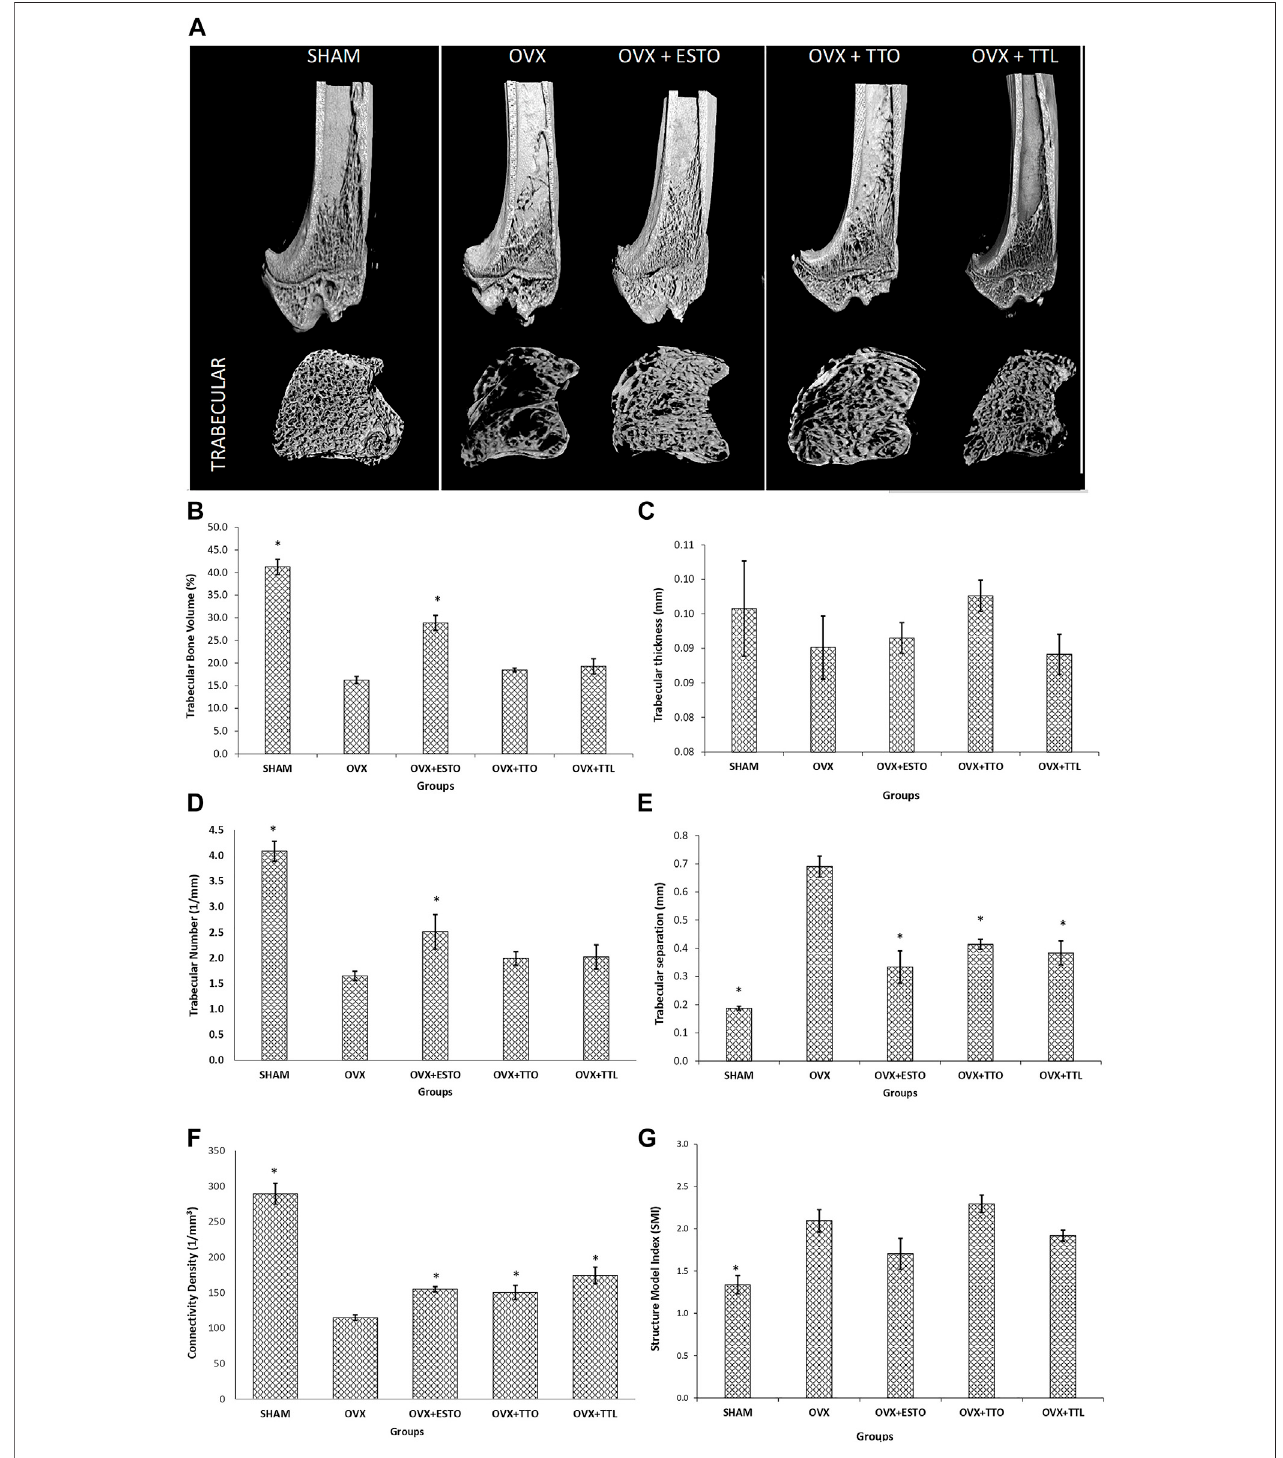
FIGURE 5 | Microcomputed tomography (micro-CT) parameters. (A) Three-dimensional (3D) images of tibial trabecular and cortical trabecular bones. (B) Trabecular bone volume of the tibial trabecular bone. (C) Trabecular thickness of the tibial trabecular bone. (D) Trabecular number of the tibial trabecular bone. (E) Trabecular separation of the tibial trabecular bone. (F) Connectivity density of the tibial trabecular bone. (G) Structure model index (SMI) of the tibial trabecular bone. SHAM, sham-operated group; OVX, ovariectomized control group; OVX + ESTO, ovariectomized + oral estrogen; OVX + TTO, ovariectomized + oral tocotrienol; OVX + TTL, ovariectomized + local injection of tocotrienol. *Signi fi cant difference ( p < 0.05) when compared with the ovariectomized control group (OVX). The data are expressed as mean + SEM.